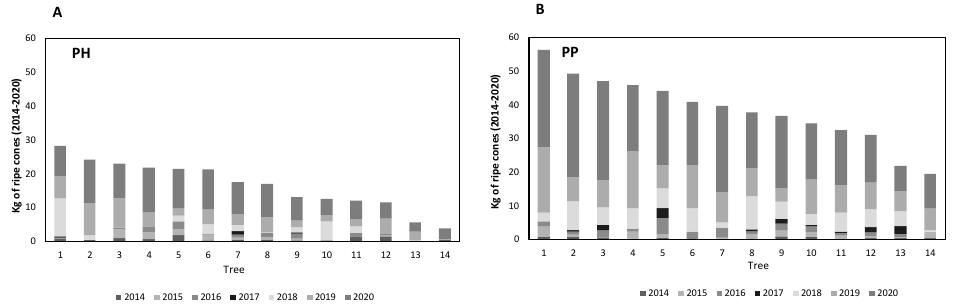
Figure 3. Accumulated kg of ripe cones for each tree of the assay, during the period of 2014 to 2020 (6 years). The trees are ordered from most to least productive. ( A ) Corresponds to PH rootstock; ( B ) corresponds to PP